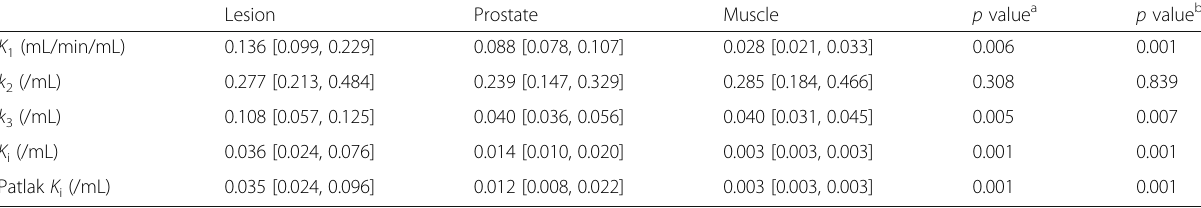
Table 1 Kinetic parameters estimated by the irreversible two-tissue-compartment model Lesion Prostate Muscle p value a p value b K 1